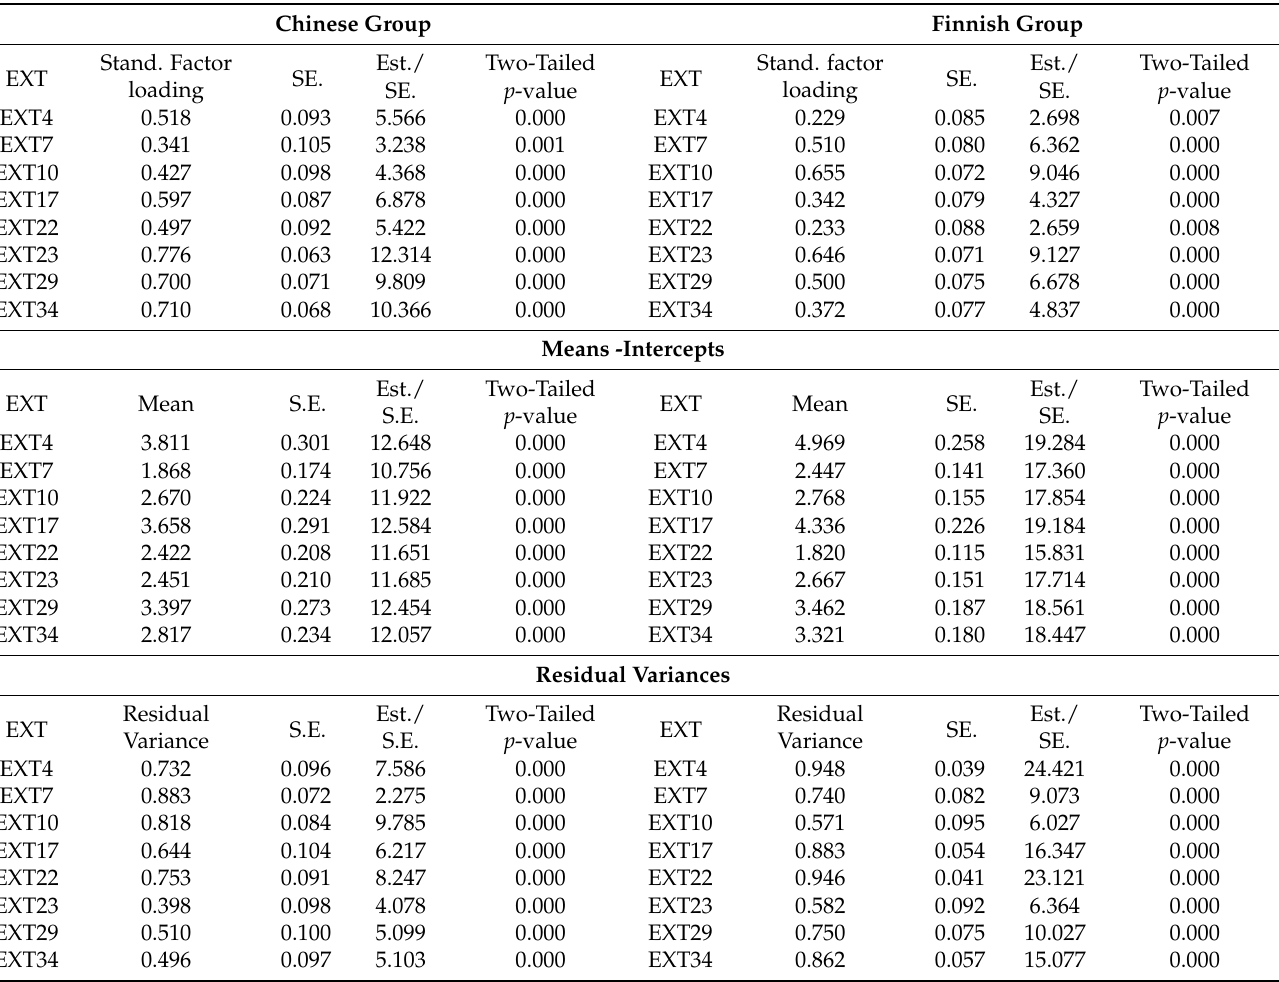
Table 5. External factors—configural factorial